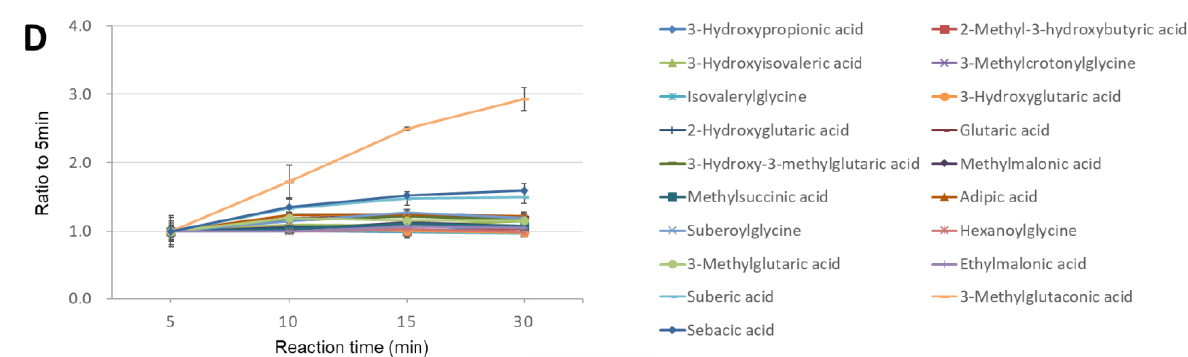
Figure 2. Investigation of sample pretreatment conditions. ( A ) Investigation of organic acid extraction solvent. Recovery rate in serum samples spiked with analytes ( n = 3 per group). Data represents means ± SD. * p value < 0.05, ** p value < 0.01 versus Acetonitrile. Effect of 3-NPH derivatization reaction by ( B ) 3-NPH concentration, ( C ) reaction temperature, and ( D ) reaction time. Data represents means ± SD.